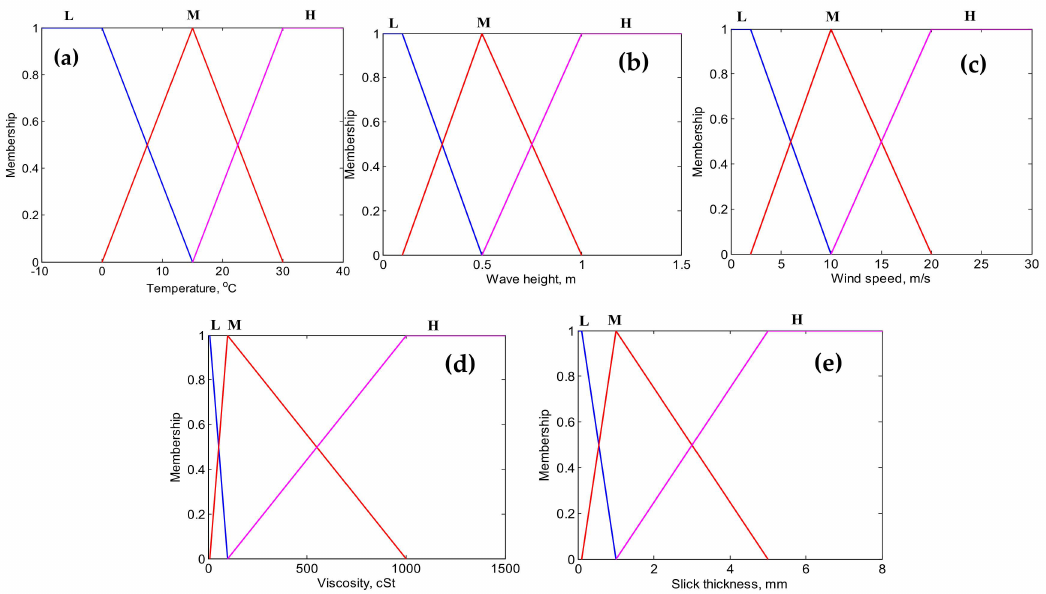
Figure 7. The membership functions of ( a ) seawater temperature, ( b ) wave energy/height, ( c ) wind speed, ( d ) oil viscosity and ( e ) slick thickness.